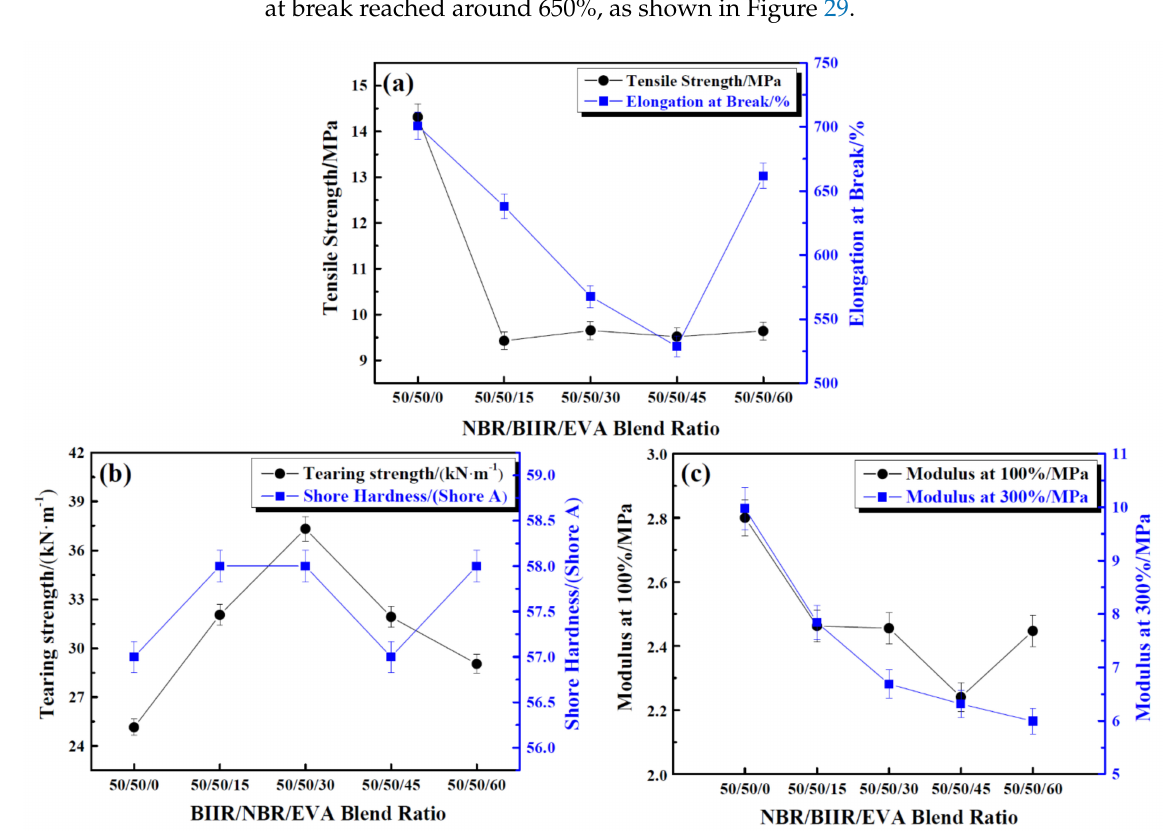
Figure 27. Mechanical properties of NBR/BIIR/EVA with various blend ratios: ( a ) Effect of tensile strength and elongation at break; ( b ) effect of tear strength and Shore hardness, and; ( c ) effects of 100% and 300% modulus [31].